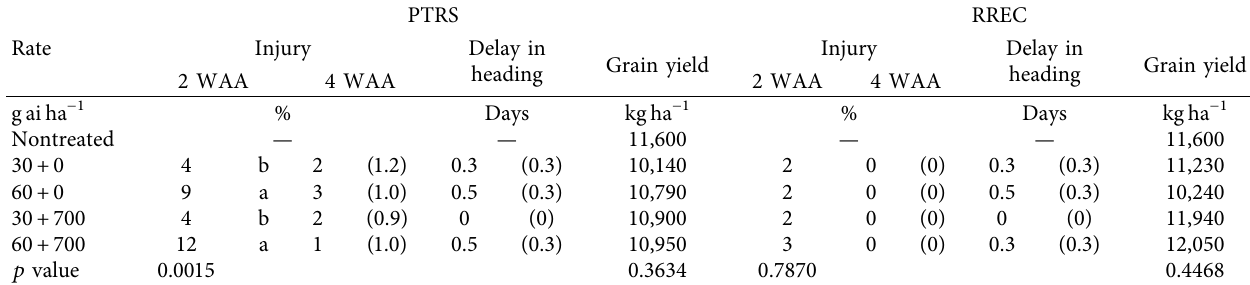
Table 10: Injury at 2 and 4 weeks after application (WAA), heading delay, and grain yield response of CLXL745 to different rates of florpyrauxifen-benzyl and malathion applied preflood a,b,c . PTRS RREC Rate Injury Delay in heading Grain yield